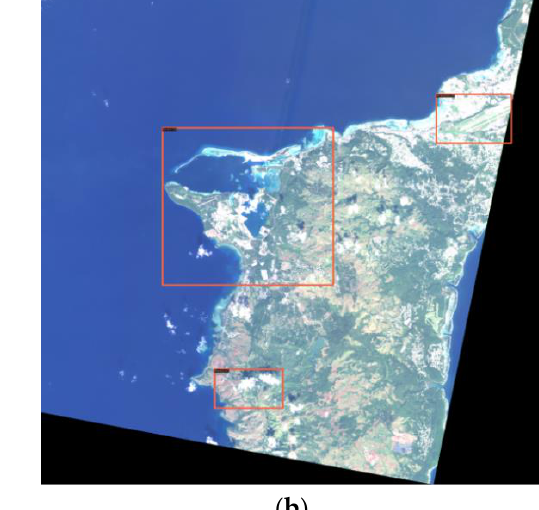
Figure 9. Port forecast comparison: ( a ) Swin-HSTPS port forecast result (confidence 0.82); ( b ) Swin Transformer port fore- cast results (confidence 0.78).